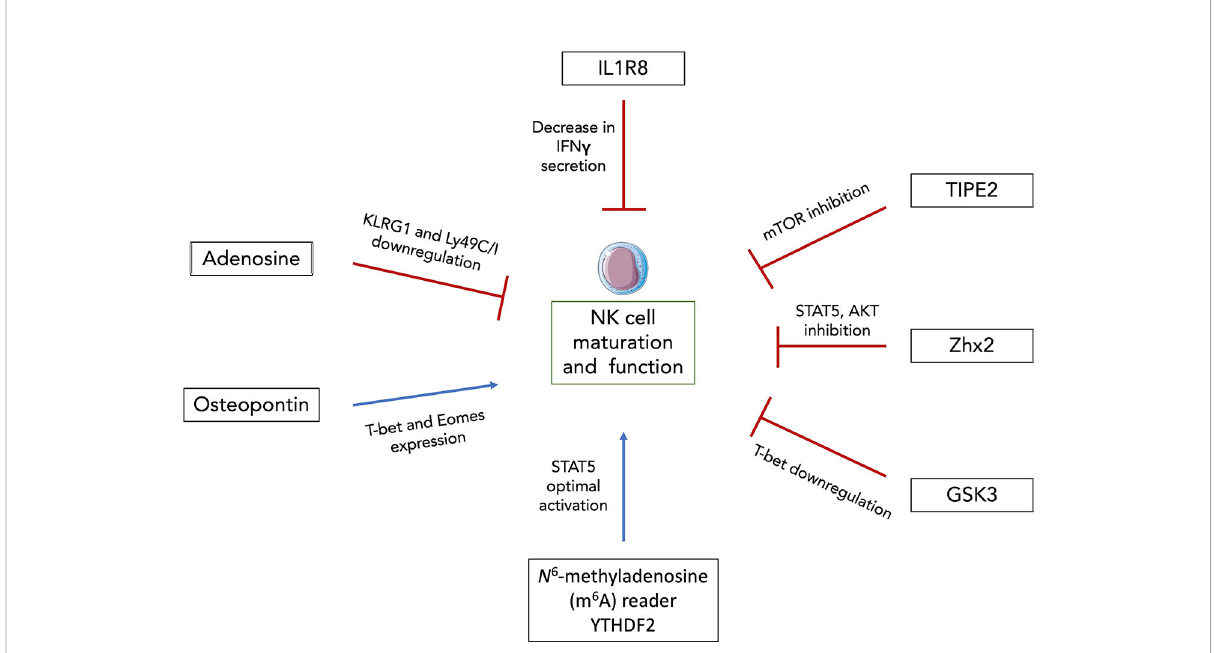
FIGURE 2 Newly discovered factors modulating NK cell maturation and function. Intracellular osteopontin (iOPN) and YTHDF2 were shown to positively regulate NK cell maturation and functional response. iOPN de fi ciency resulted in the downregulation of T-bet and Eomes expression as well as in the impairment of NK cell cytolytic activity and cytokine secretion. YTHDF2 promotes NK cell maturation, proliferation, survival and effector functions through a STAT5-YTHDF2 positive feedback loop. On the other hand, adenosine signaling, IL1R8, TIPE2, Zhx2 and GSK3 were all shown to negatively regulate NK cell maturation and anti-tumor activity through downregulation of maturation markers and/or transcription factors, decreased IFN g secretion and inhibition of diverse NK cell activating signaling pathways. Thus, these factors constitute promising targets for NK cell-based